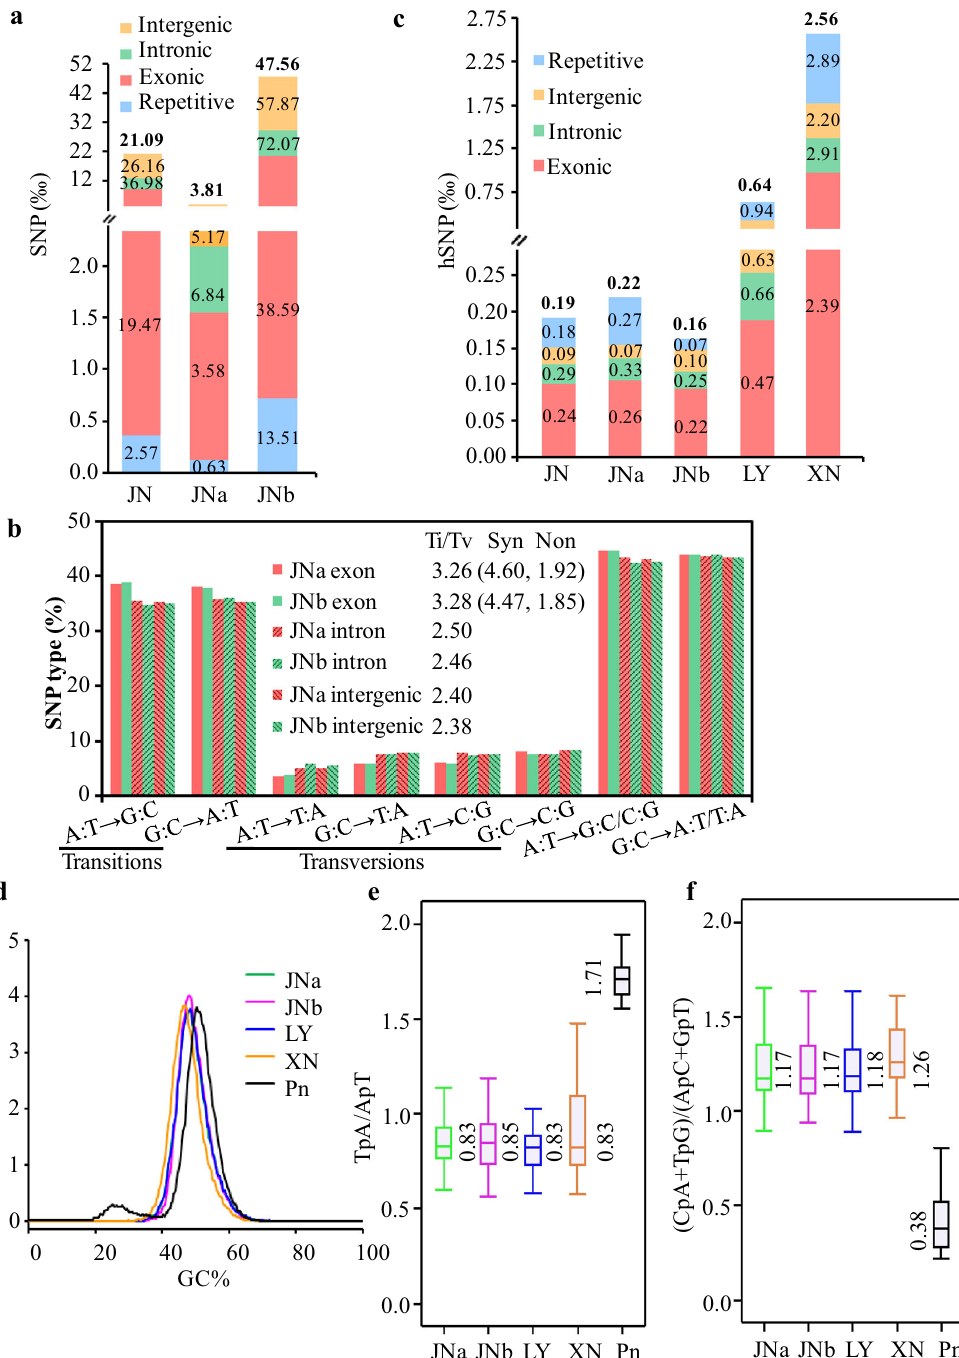
Fig. 3 Comparisons of SNP and the heterozygous SNP (hSNP) mutation spectra in Rhizoctonia spp. a SNP rates of JN or its subgenomes were estimated in relation to LY sequences and divided into four genomic regions with the ratios presented in the fi gure. The numbers in bold on the tops of the columns are the total SNP ratios. b SNP mutation patterns and ratios of transition (Ti) to transversion (Tv) in the data sets. A:T → G:C for A-to-G and T-to-C mutations, A:T → G:C/C:G for A and T-to-G or C mutations, and parity of reasoning for the others. Syn for synonymous variants and Non for nonsynonymous variants. c Distribution of hSNP rates in Rhizoctonia spp.. The hSNP rates were divided into four genomic regions as described in a , and obtained by using SOAPaligner and SOAPsnp software. d Distribution of GC contents calculated from 500 bp non-overlapping windows. e , f The RIP indices of TpA/ApT and (CpA + TpG)/(ApC + GpC) from repeat family of each Rhizoctonia data set, respectively. The positive control of Parastagonospora nodorum (Pn) showed a bimodal GC distribution and had a strong RIP 7 lower, and equal expression level in homeolog gene pair, levels of homeolog genes and found about half of the gene pairs respectively) as previously described 34 . The median Ka/Ks and displayed homeolog expression dominance (Fig. 5f and Supple- Ka values of dominant and subordinate genes were markedly mentary Fig. 16a). The homeolog expression dominant genes higher than those of neutral genes (Fig. 5g and Supplementary were classi fi ed as dominant, subordinate, and neutral (i.e., higher,